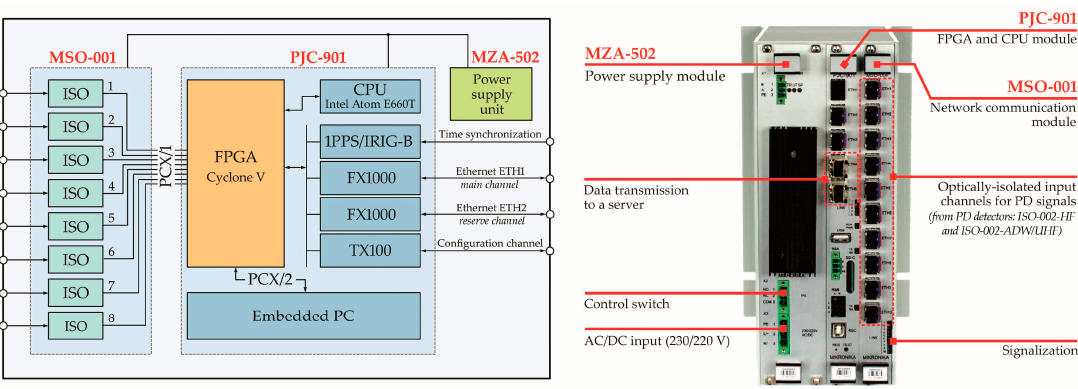
Figure 22. Schematic diagram and photograph of developed multi-channel data concentrator module MPD-001.